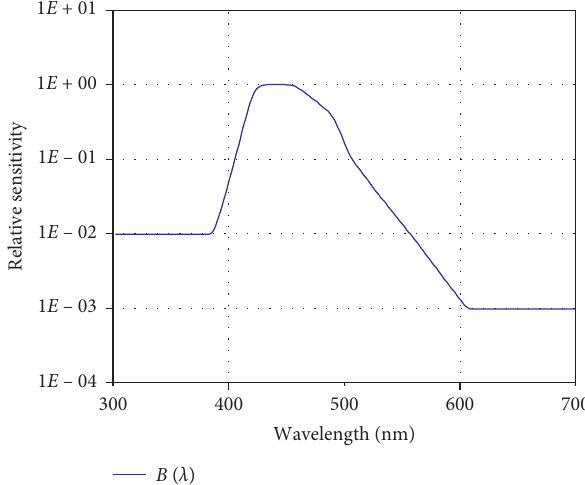
Figure 7: The spectral weight function B ( λ ) of blue light hazard on the